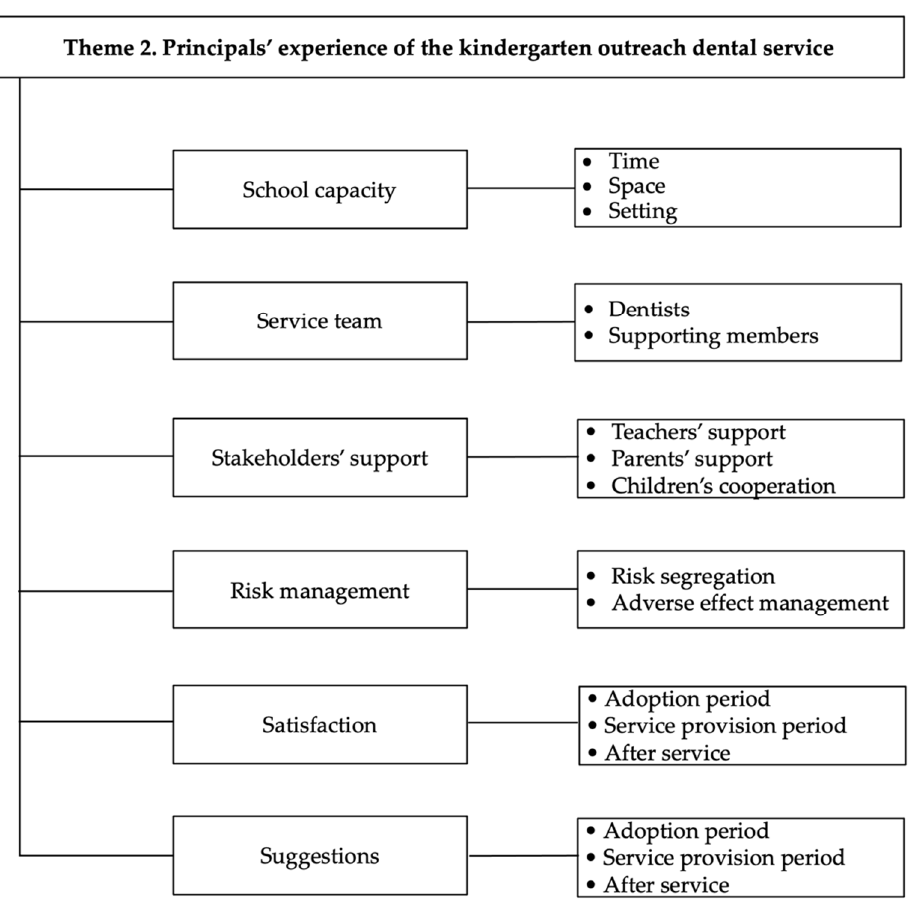
Figure 2. Principals’ experience of the kindergarten outreach dental service.